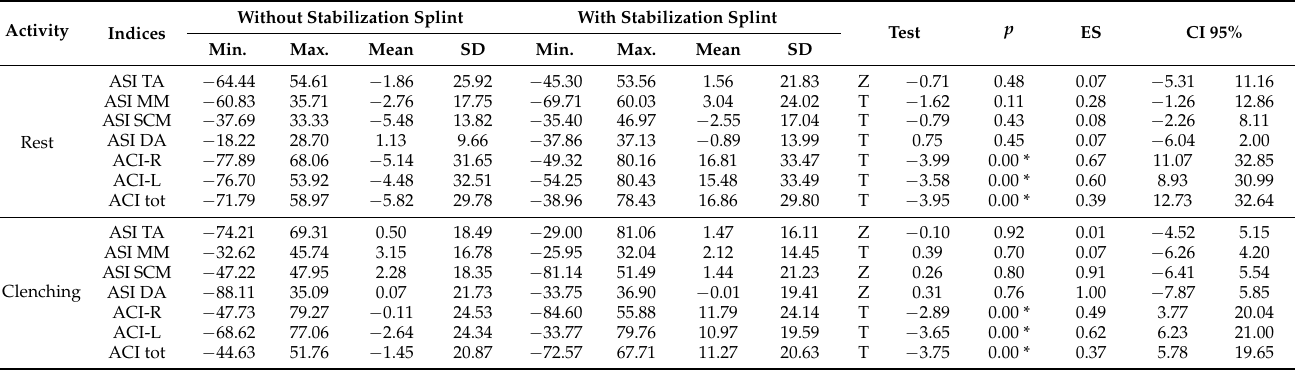
Table 5. Comparison of asymmetry and activity indices at rest and during maximal tooth clenching with and without stabilization